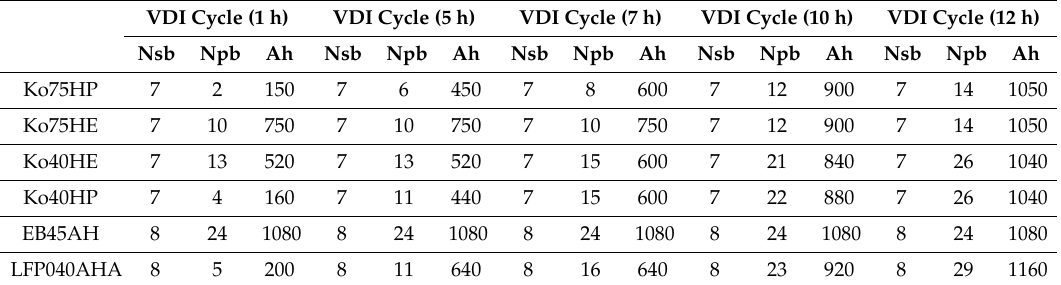
Figure 7. ( a ) Kilowatt hour per battery pack found after repeating VDI cycle. ( b ) Battery weight per battery per VDI cycle. Table 3. Number of cells and capacity for each battery and VDI cycle